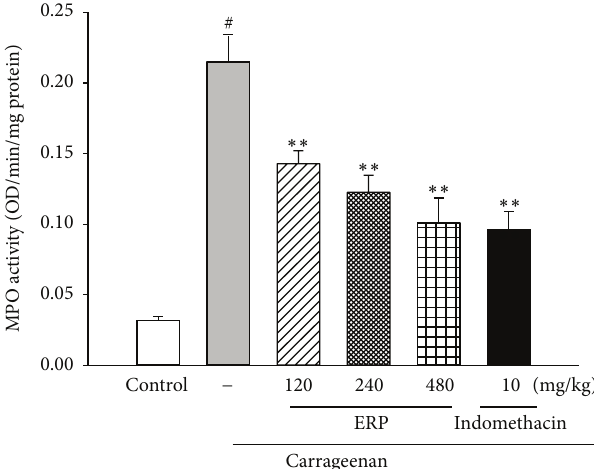
Figure5:EffectofERPoncarrageenan-inducedtheactivityofMPO in mouse paw edema. Data represented the mean ± S.E.M. ( 𝑛 = 10 ). # 𝑃 < 0.01 compared to the control group; ∗ 𝑃 < 0.05 and ∗∗ 𝑃 < 0.01 compared to the carrageenan-control